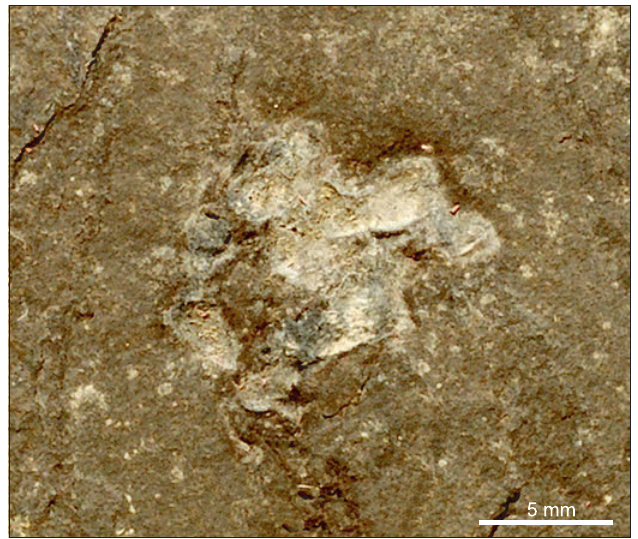
Fig. 14. A small, triangular, pointed posteriorly, gladius, indicative a coleoid prey of Phragmoteuthis bisinuata (Bronn, 1859) (GBA 2006/011/0028); lower Carnian, Upper Triassic, Cave del Predi, NE Italy (enlarged detail of Fig.